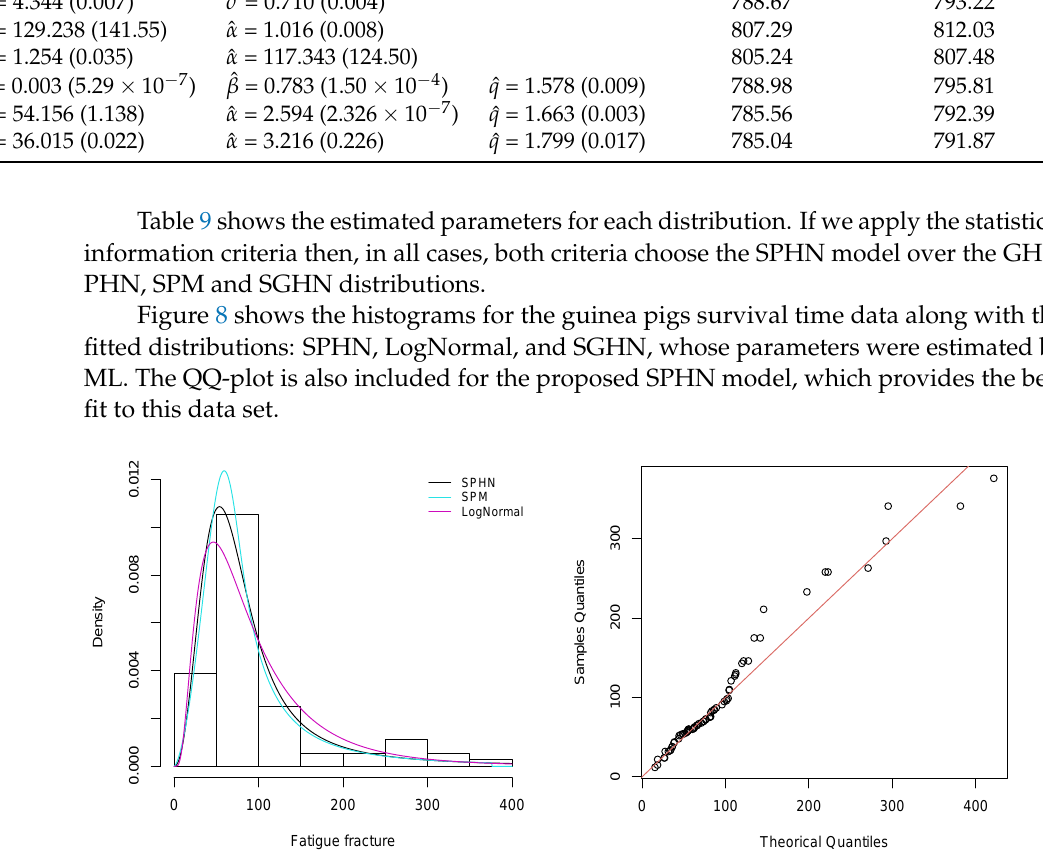
Table 9. Estimated values, SE and information criteria